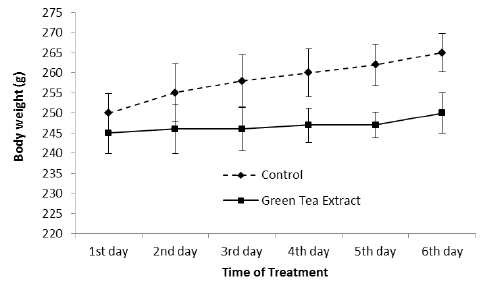
Figure 3. Green tea extract can reduces FFR body weight signifi cantly for 6 days of treatment (p < 0.01).